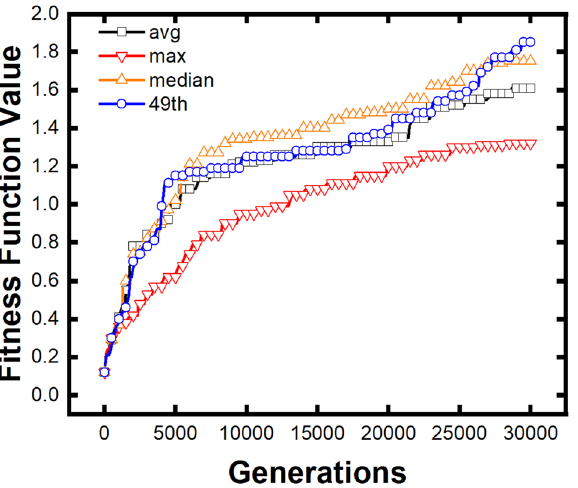
Figure 5. Comparison of the optimization efficiency between different reference values. Using the median value and golden section points have higher optimization efficiency, while using the average value is less efficient, and using the maximum value is least